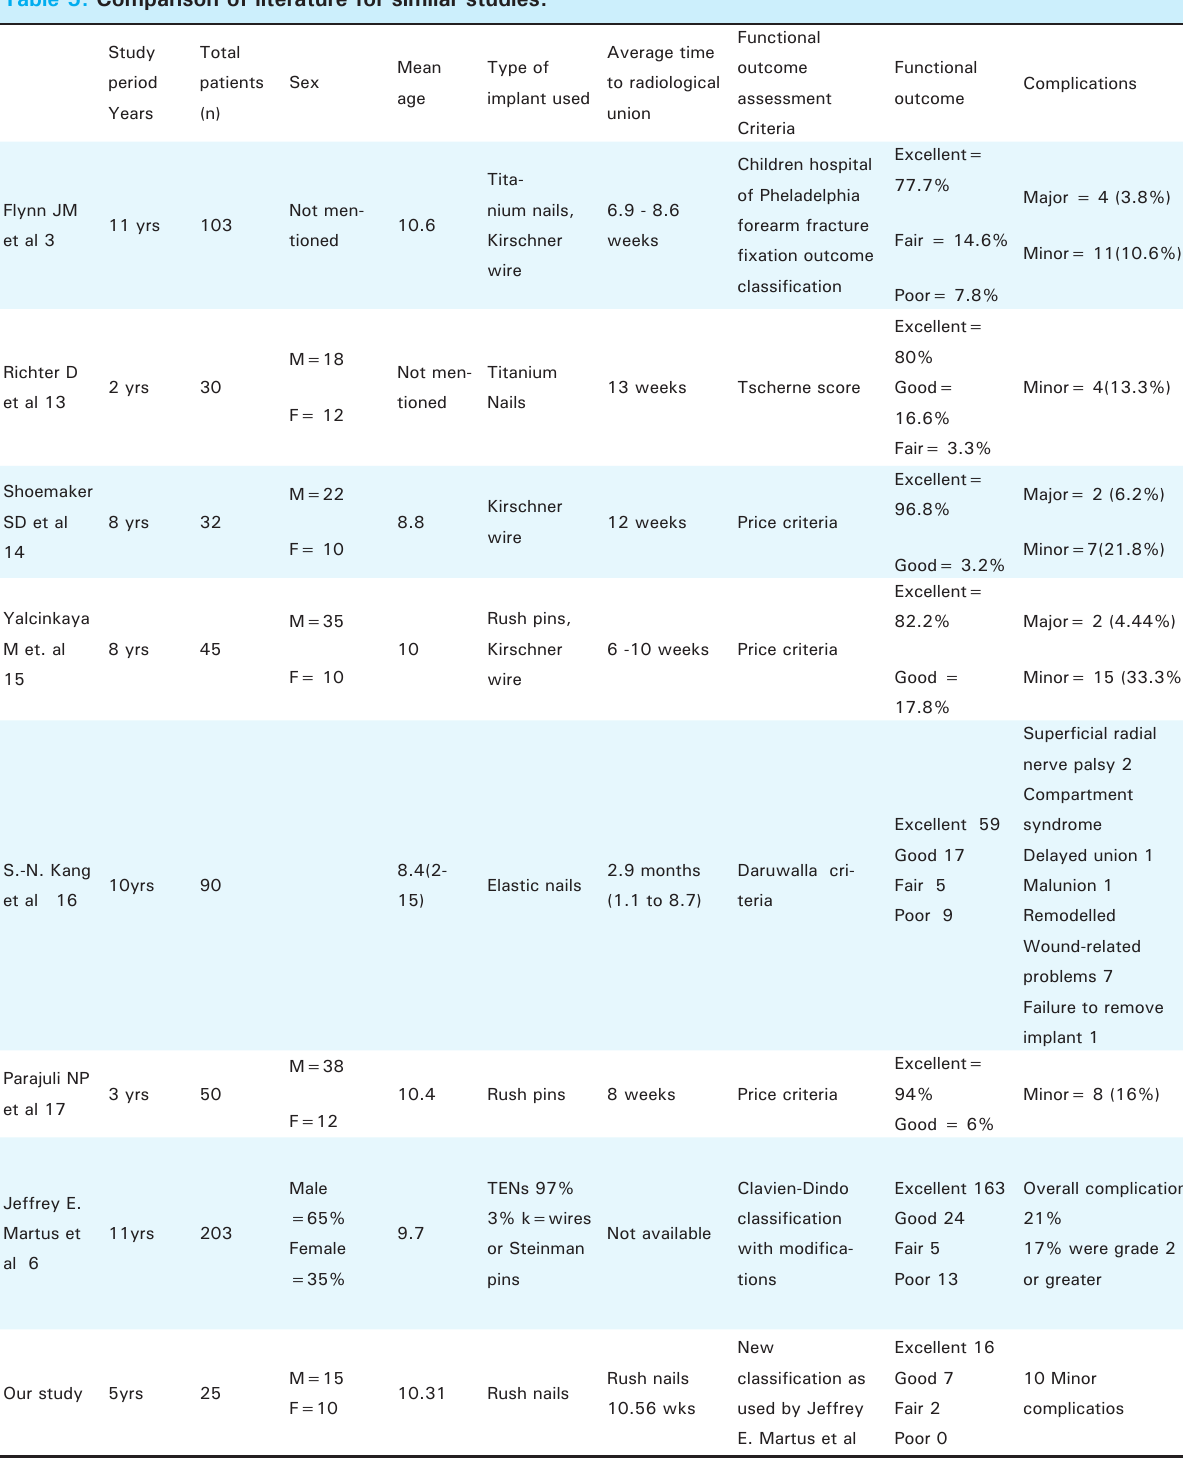
table 5. Comparison of literature for similar